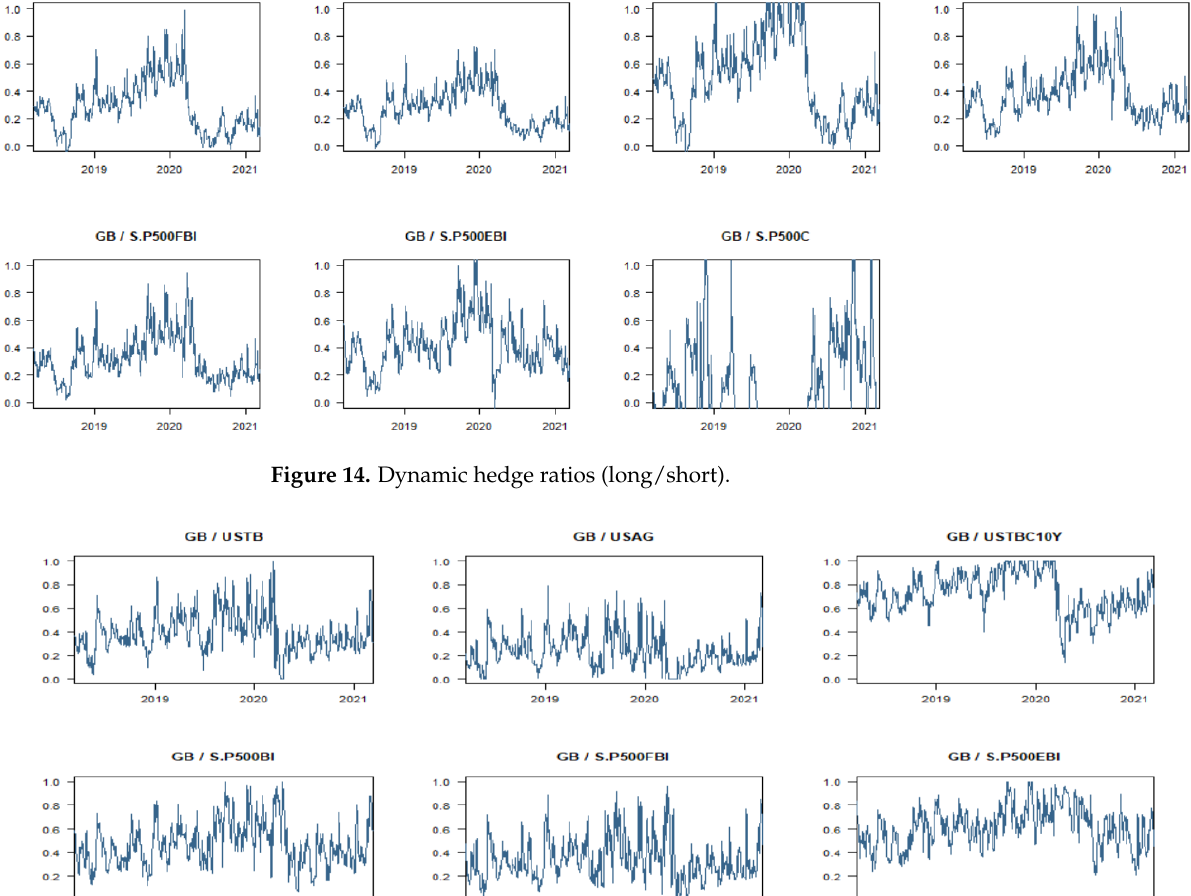
Figure 13. Dynamic Conditional Correlations.